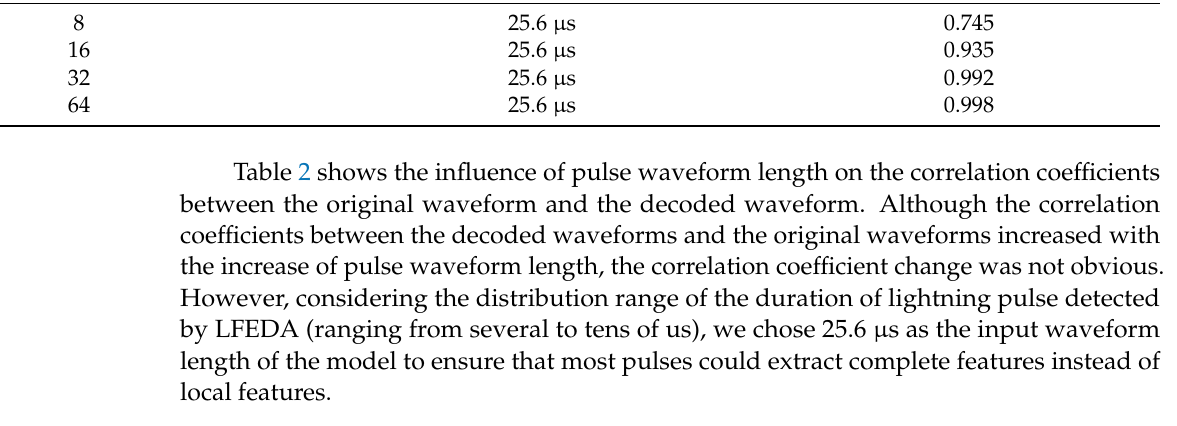
Table 2. The correlation coefficients between the original waveform and the waveform decoded by different lengths of the pulse